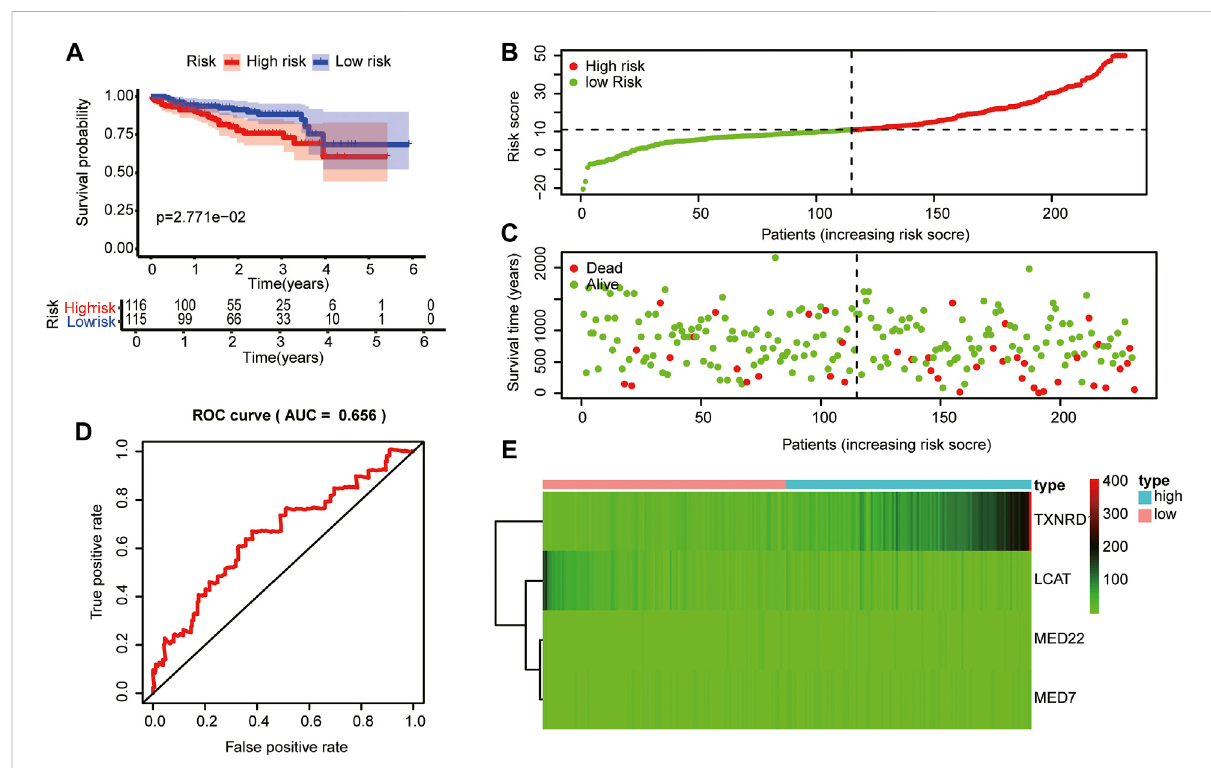
FIGURE 7 Validation of the risk model in the in the Internal Cancer Genome Consortium (ICGC) database.